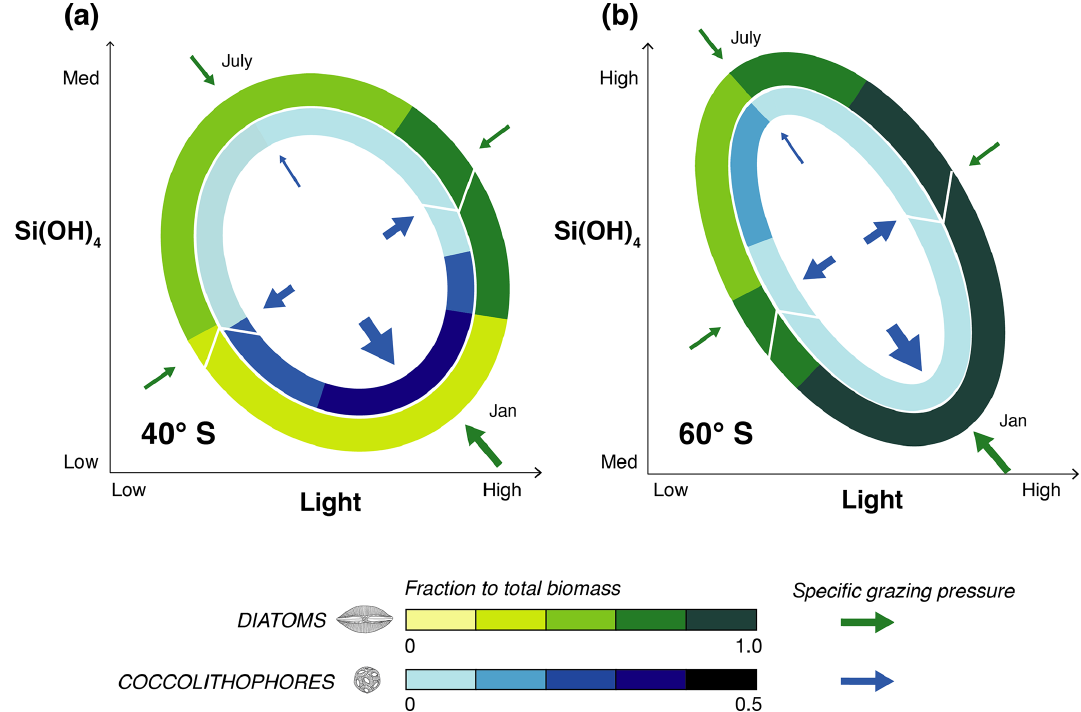
Figure 8. Sketch summarizing the results from ROMS–BEC: relative importance of coccolithophores (inner circle) and diatoms (outer circle) for total phytoplankton biomass over time in light–silicic acid space for (a) 40 ◦ S and (b) 60 ◦ S. Note the different scales for coccolithophores and diatoms. Arrows in the sketch indicate the course of time (white) and the strength of the specific grazing pressure on coccolithophores (blue) and diatoms